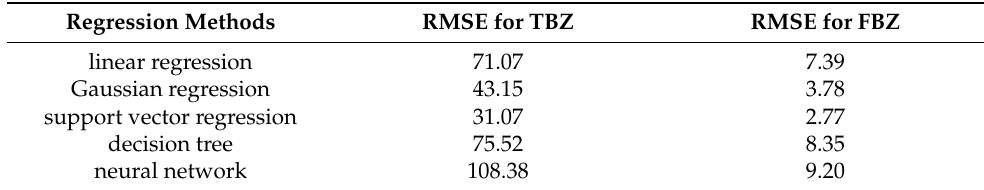
Table 6. Performance of Different Algorithms for Extraction Method.